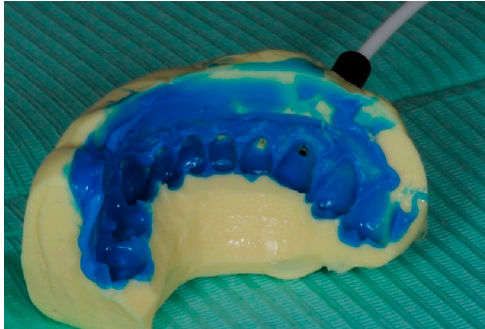
Figure 3. Position of the optic probe in the impression.